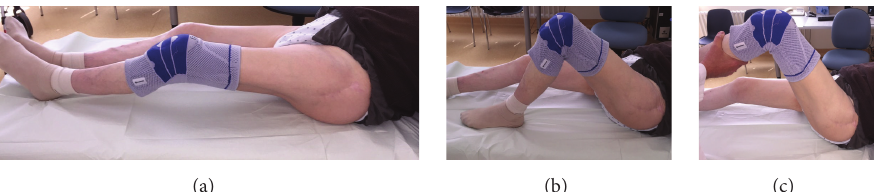
Figure 6: Clinical examination two years and eight months postoperatively. Extension/flexion of the left hip 0 ∘ -20 ∘ -70 ∘ , abduction/adduction 40 ∘ -0 ∘ -10 ∘ , and rotation 10 ∘ -0 ∘ -10 ∘